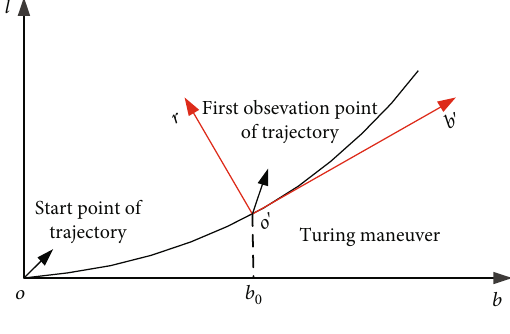
Figure 3: New maneuver coordinate B ′ L ′ U